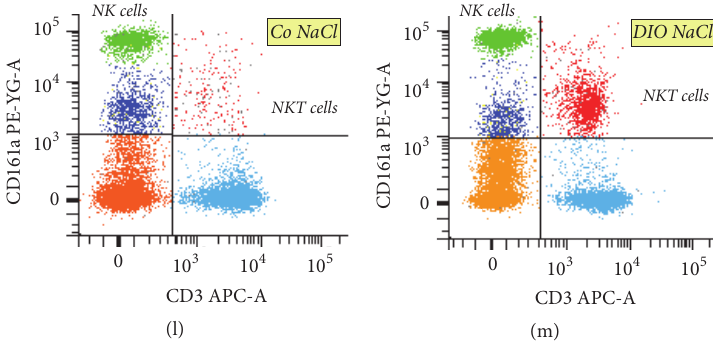
Figure 5: Exemplary FACS plots and frequencies of different leukocytes subset populations in peripheral blood of normal weight [Co] and obese [DIO] rats treated with NaCl or azoxymethane (AOM). Total T lymphocytes (a, c), monocytes (b, d), B lymphocytes (a, e), NKT cells (j, l, m), and NK cells (k, l, m) are demonstrated as percentage of peripheral blood mononuclear cells (PBMCs). NK cells are represented by cells with CD 161 a bright and CD3 − expression and denoted with NK cells (green colored population). CD4+ T lymphocytes (f, h, i) and CD8+ T lymphocytes (g, h, i) are illustrated as percentage of total T lymphocytes. Differences in frequencies of CD4+ and CD8+ T lymphocytes (h, i) as well as differences in NKT cell frequency (l, m) in normal weight (h, l) and obese rats (i, m) are exemplary demonstrated. Data are expressed as mean ± SEM of 𝑛 = 11 –14 animals per group. # 𝑃 < 0.05 compared to NaCl-treated control group; ∗ 𝑃 < 0.05 , compared to appropriate control group. § 𝑃 < 0.05 , §§ 𝑃 < 0.01 , two-way-ANOVA, normal weight control groups compared to DIO